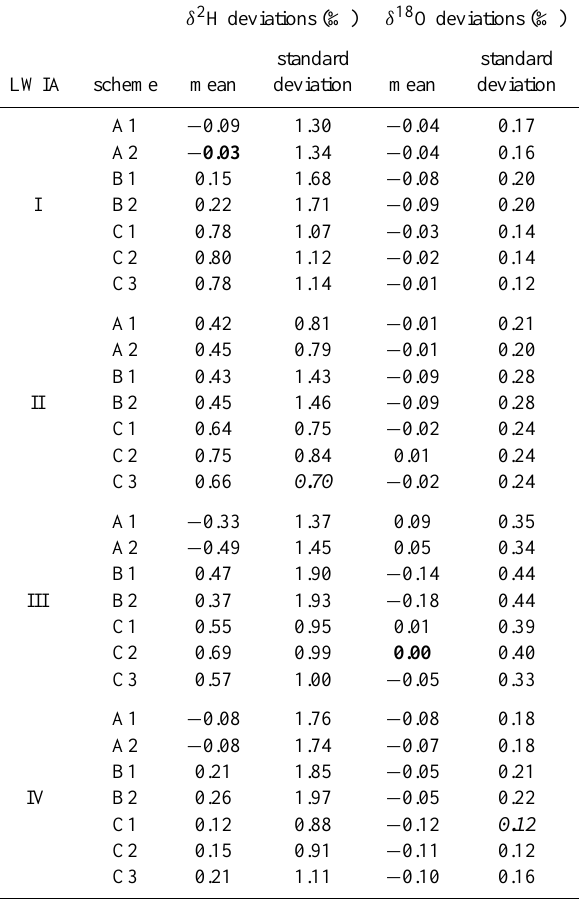
Table 2. Basic descriptive statistics for δ 2 H and δ 18 O laser spectro- scope-mass spectrometer deviations for the different schemes and for the four analyzers (in bold is the mean value closest to zero for each isotope; in italics is the lowest standard deviation value for each